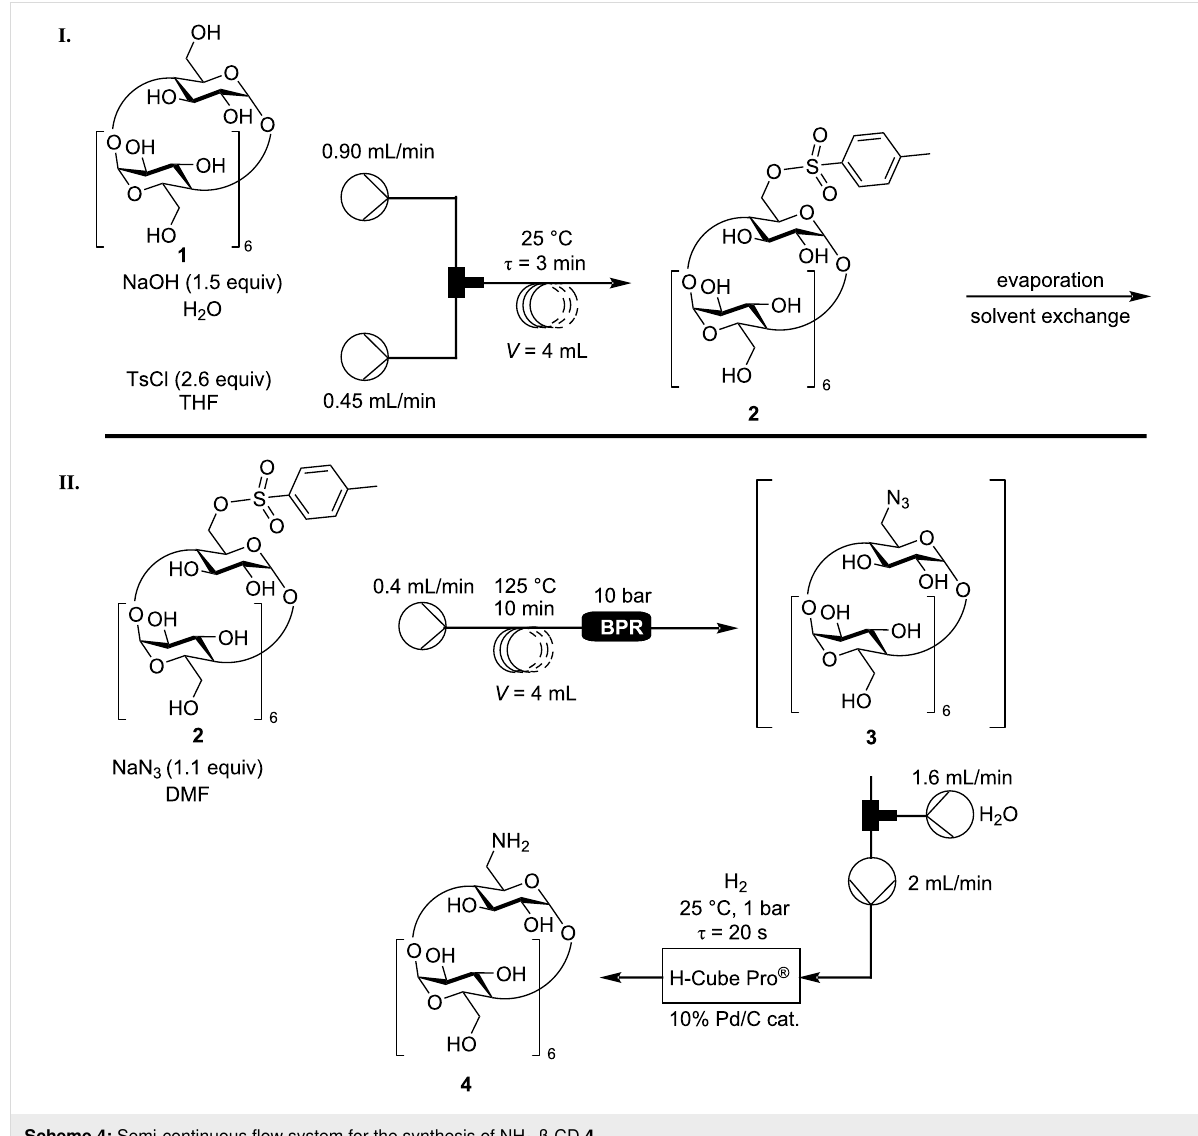
Scheme 4: Semi-continuous flow system for the synthesis of NH 2 - β -CD 4